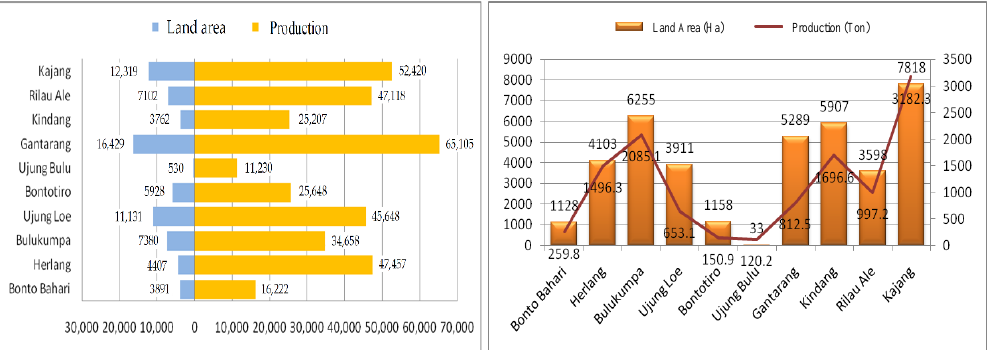
Figure 3. Agricultural and Plantation Production by District in Bulukumba Regency. (Source: Reference [29]).